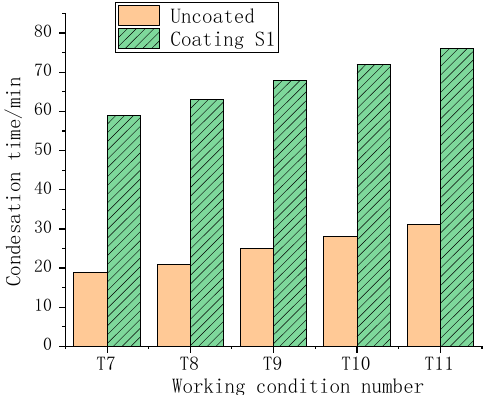
Figure 16. Effect of different dew point temperature differences on the occurrence time of condensation.